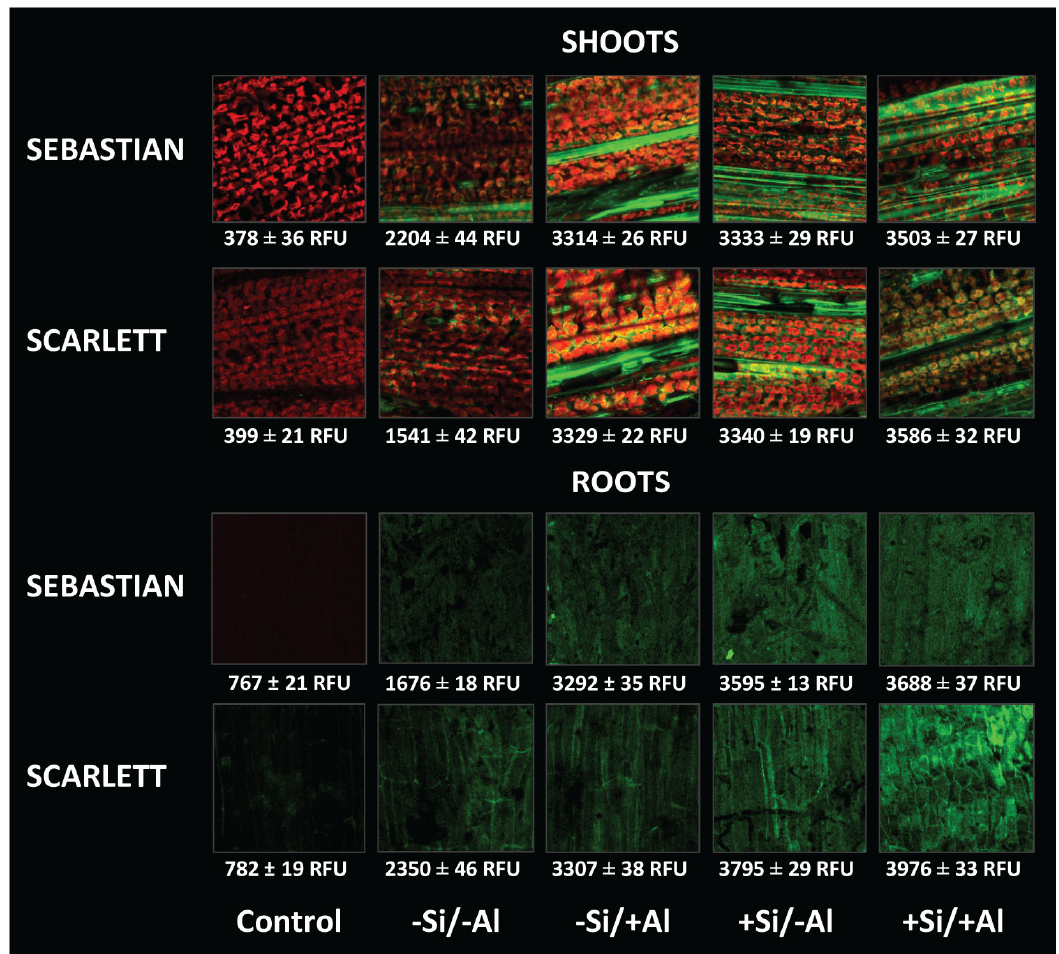
Figure 4. Visualization of lignin contents (green color) in barley roots and shoots of Sebastian and Scarlett cultivars, harvested after 21 days. Treatments were 0 or 0.2 mM Al, combined with 0 or 2 mM Si. The detection of safranine fluorescence was expressed as relative fluorescence unit (RFU). Values represent the mean of three replicates per treatment ± SD.